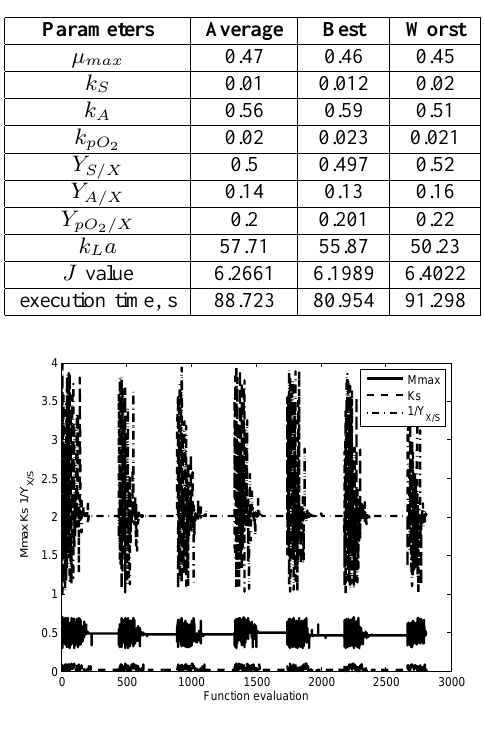
Fig. 1. Parameters estimation through